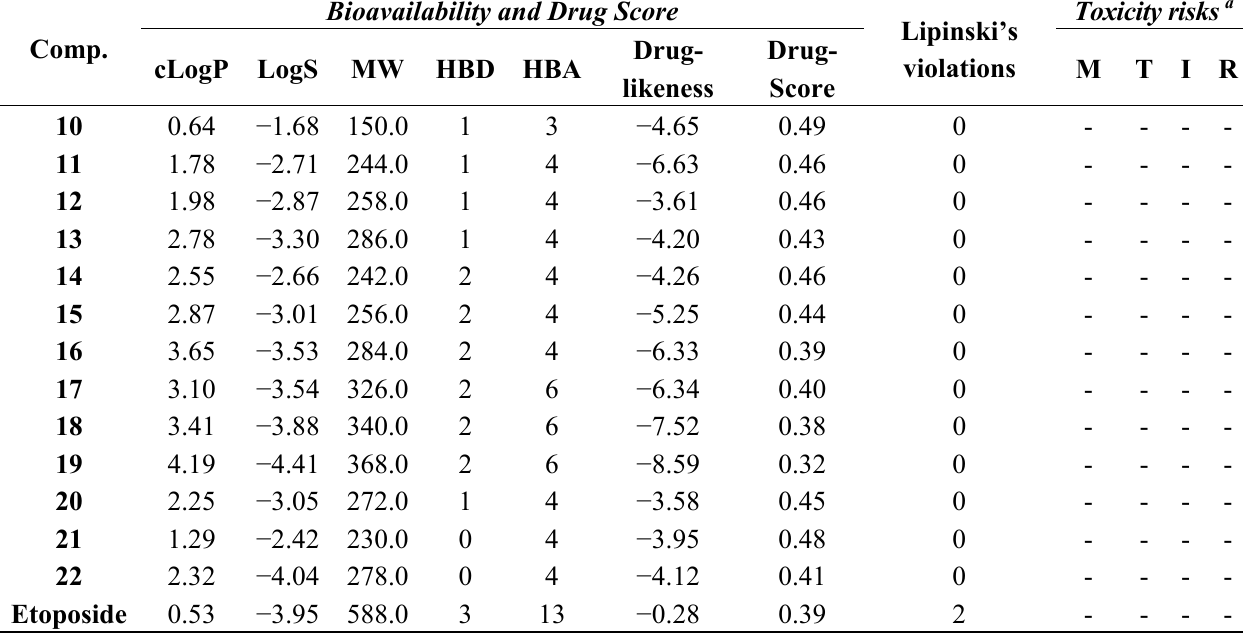
Table 4. Predicted drug-likeness properties and toxicity risks of compounds 10 – 22 and epotoside calculated by Osiris package. Comp.